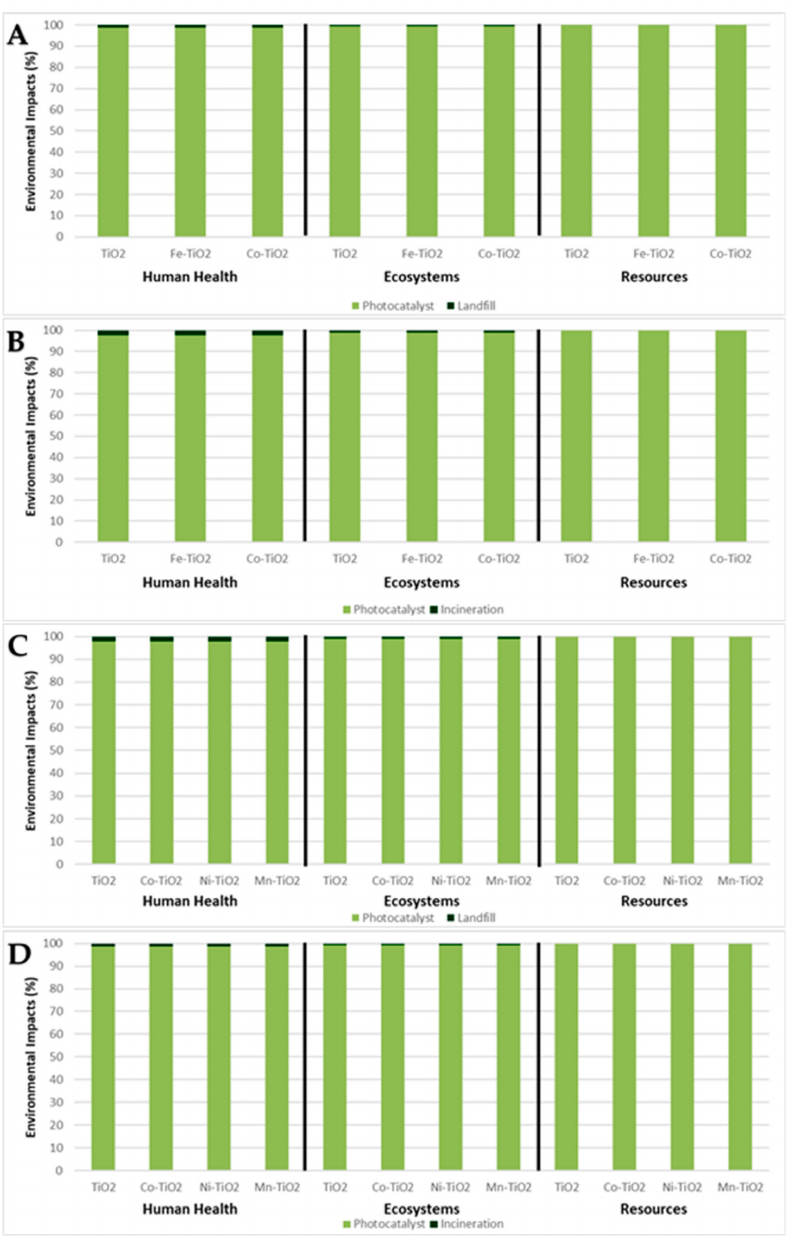
Figure 4. Relative environmental impacts of di ff erent TiO 2 photocatalysts synthesis for CBZ degradation considering disposal in Landfill ( A ) or Incineration ( B ), as well for MO degradation according to Landfill ( C ) and Incineration ( D )